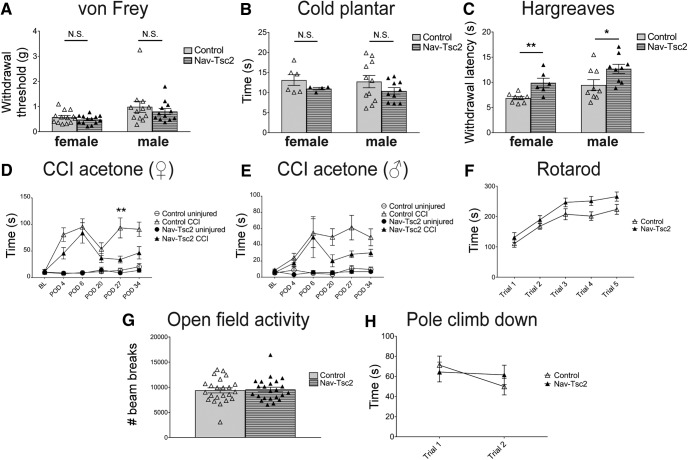
Nav-Tsc2 mice shows normal responses to mechanical and cold stimuli but have decreased heat sensitivity and injury-induced cold hypersensitivity. A–C, Sensory behavior analysis of control and Nav-Tsc2 mice. A, Withdrawal threshold for control and Nav-Tsc2 male and female mice using von Frey test; N = 12–13. B, Latency to paw withdrawal from cold stimulus; N = 4–11. C, Latency to paw withdrawal in Hargreaves test. Individual animals plotted with mean ± SEM; N = 9–13. D, E, Time spent in spontaneous pain behavior as a result of acetone application to paw of uninjured (circles) or injured (triangles) hindpaw at baseline and indicated time after CCI for female (D) and male (E) Nav-Tsc2 mice (closed shapes) and their control littermates (open shapes). Plotted as mean ± SEM; N = 8–11. BL, baseline. POD, post-operative day. F–H, Sensorimotor battery showed no difference between control and Nav-Tsc2 mice. F, Time to fall off an accelerating Rotarod was measured for Nav-Tsc2 mice (closed) and their control littermates (open). Data are graphed for each of five trials; N = 17. G, Open field locomotor behavior was assessed over 1 h in Nav-Tsc2 mice and their control littermates with individual data points plotted; N = 23. H, Time required to climb down a pole was measured for Nav-Tsc2 mice (closed) and their control littermates (open). Data graphed for each of two trials; N = 22. Data in G, H shown as mean ± SEM; N.S. p > 0.05, *p < 0.05, **p < 0.01.